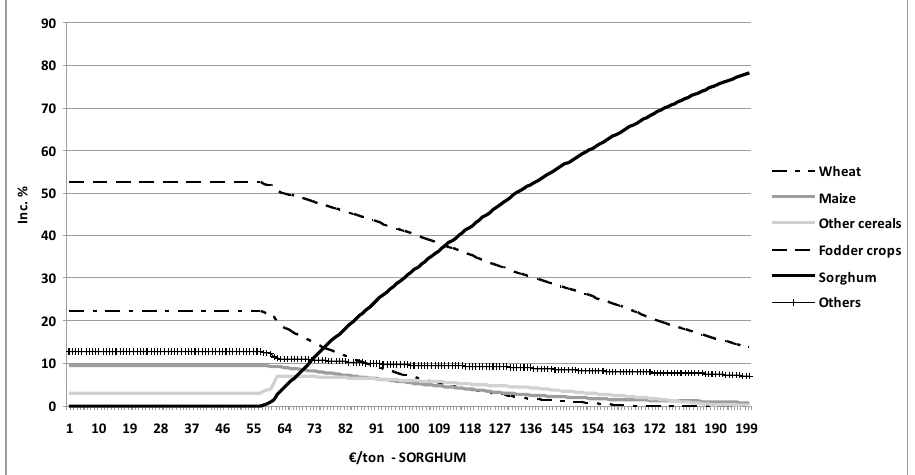
Figure 4. Evolution of the specific incidence of each crop on the regional production plan (Parma